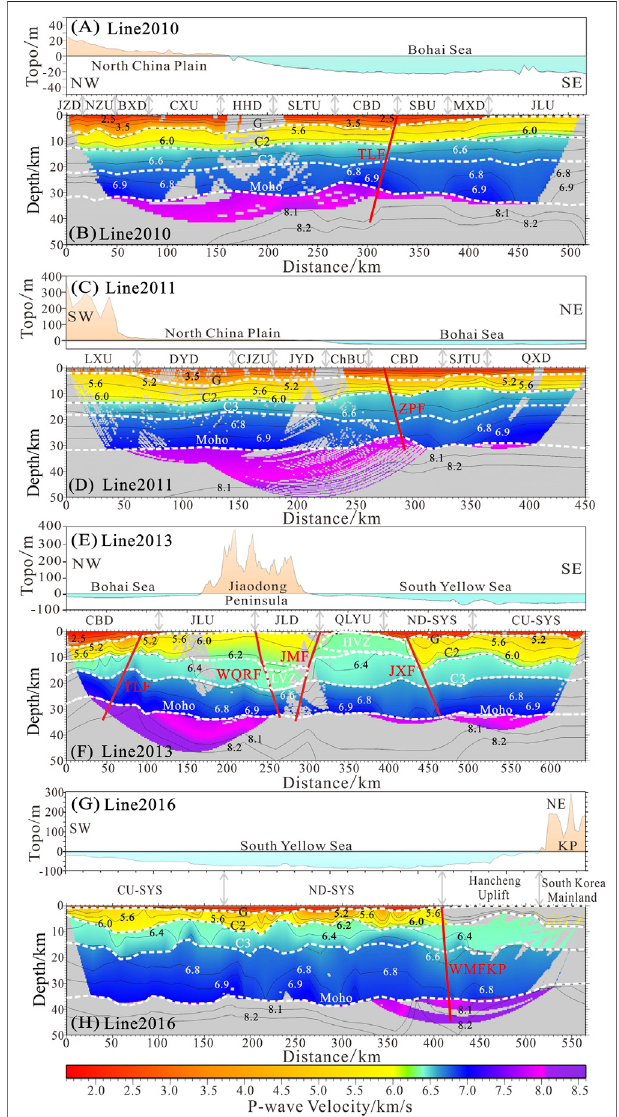
FIGURE 9 | Topography and Vp model of Line 2010 (A,B) , Line 2011 (C,D) , Line 2013 (E,F) , and Line 2016 (G,H) , respectively. Model regions without ray coverage are shown in gray. The main tectonic units, with boundaries shown in gray arrows, are annotated between the maps of topography and Vp model. The abbreviations of the names of tectonic units are listed next. JZD, Jizhong Depression; NZU, Niutuozhen Uplift; BXD, Baxian Depression; CXU, Cangxian Uplift; HHD, Huanghua Depression; SLTU, Shaleitian Uplift; CBD, Central Bohai Depression; SBU, Southern Bohai Uplift; MXD, Miaoxi Depression; JLU, Jiaoliao Uplift; LXU, Luxi Uplift; DYD, Dongying Depression; CJZU, Chenjiazhuang Uplift; JYD, Jiyang Depression; ChBU, Chenbei Uplift; SJTU, Shijiutuo Uplift; QXD, Qinxi Depression; JLD, Jiaolai Depression; QLYU, Qianliyan Uplift; ND-SYS, Northern Depression of SYS; CU-SYS, Central Uplift of SYS. The white dashed lines indicate the main interfaces (G, C2, C3, and Moho) in the Vp model, with velocity contours in black solid lines. The red lines are locations of the main great faults, which can be found in and have the same abbreviations as Figure 3